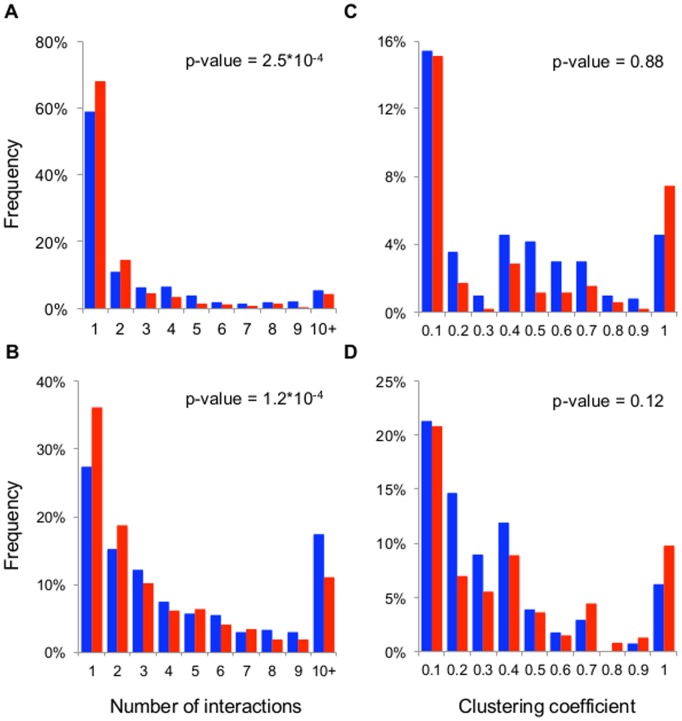
Histograms of the distributions of degree and clustering coefficient for alternatively spliced genes and genes with a single transcript.A and C, C. elegans. B and D, D. melanogaster. In blue, alternatively spliced genes. In red, genes with a unique transcript. P-values calculated using Mann-Whitney test and FDR correction for the equivalent comparisons.